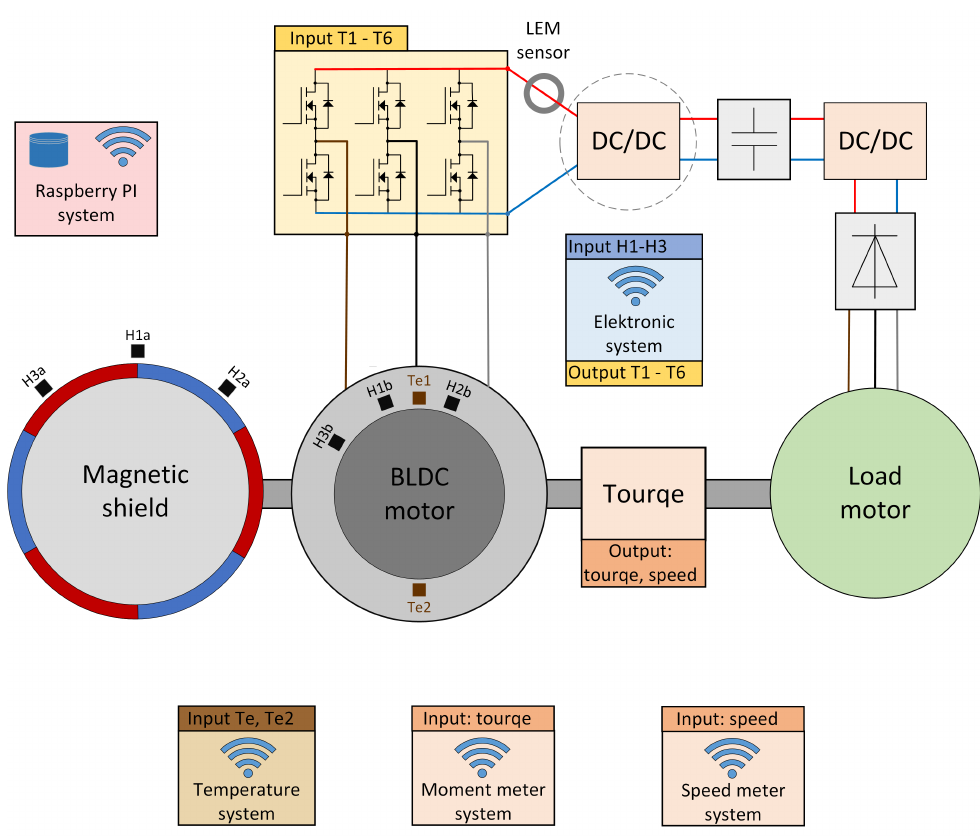
Figure 1. Scheme of the construction of the BLDC engine research stand with the load and marked mea- suring apparatus with sensors used to measure all features like speed, momentum (torque), temperature.